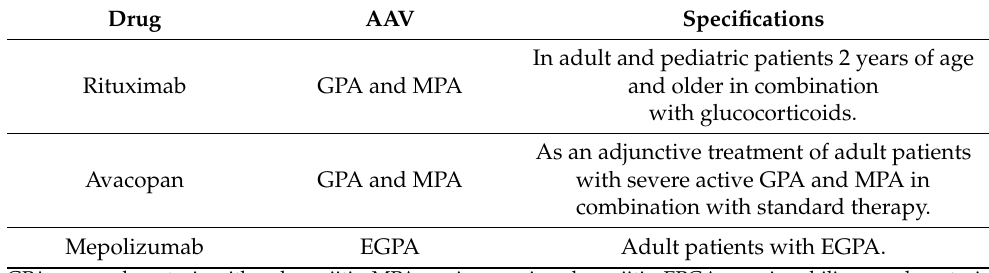
Table 2. FDA approved indications for new AAV drugs. Drug